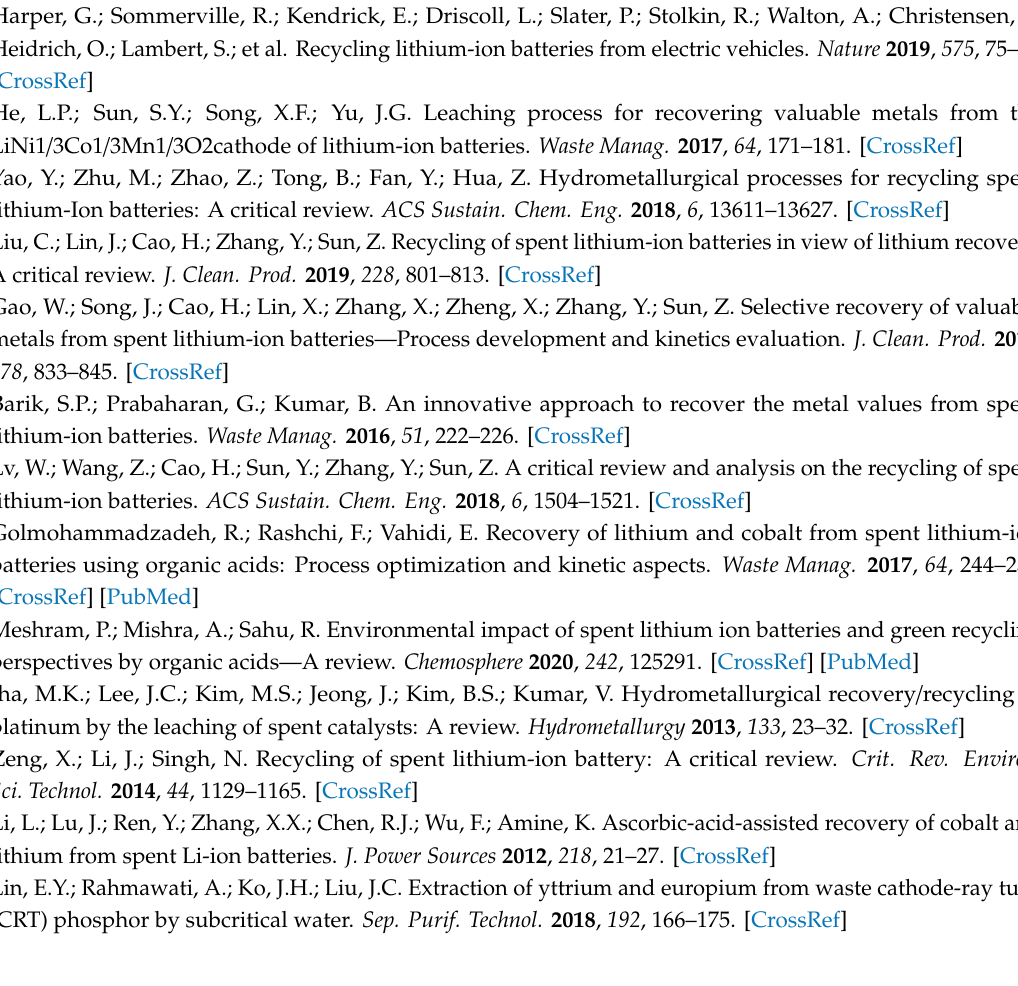
Supplementary Materials: The following are available online. Figure S1: Kinetic plot of Co extraction at di ff erent temperature using 0.5 M HCl with 10 g / L of solid to liquid ratio, Figure S2: Kinetic plot of Li extraction at di ff erent temperatures using 0.5 M HCl with 10 g / L of solid to liquid ratio, Figure S3: Kinetic plot of Mn extraction at di ff erent temperature using 0.5 M HCl with 10 g / L of solid to liquid ratio, Figure S4: Kinetic plot of Co extraction at di ff erent temperatures using 0.5 M ascorbic acid with 10 g / L of solid to liquid ratio, Figure S5: Kinetic plot of Li extraction at di ff erent temperatures using 0.5 M ascorbic acid with 10 g / L of solid to liquid ratio, Figure S6: Kinetic plot of Mn extraction at di ff erent temperatures using 0.5 M ascorbic acid with 10 g / L of solid to liquid ratio, Figure S7: XRD spectra of leaching residues of ascorbic acid and HCl after subject to SWE, Table S1: Kinetic parameters of Co extraction with 0.5 M HCl, Table S2: Kinetic parameters of Li extraction with 0.5 M HCl, Table S3: Kinetic parameters of Mn extraction with 0.5 M HCl, Table S4: Kinetic parameters of Co extraction with 0.5 M ascorbic acid, Table S5: Kinetic parameters of Li extraction with 0.5 M ascorbic acid, Table S6: Kinetic parameters of Mn extraction with 0.5 M ascorbic acid, Table S7: Activation energy using Arrhenius equation